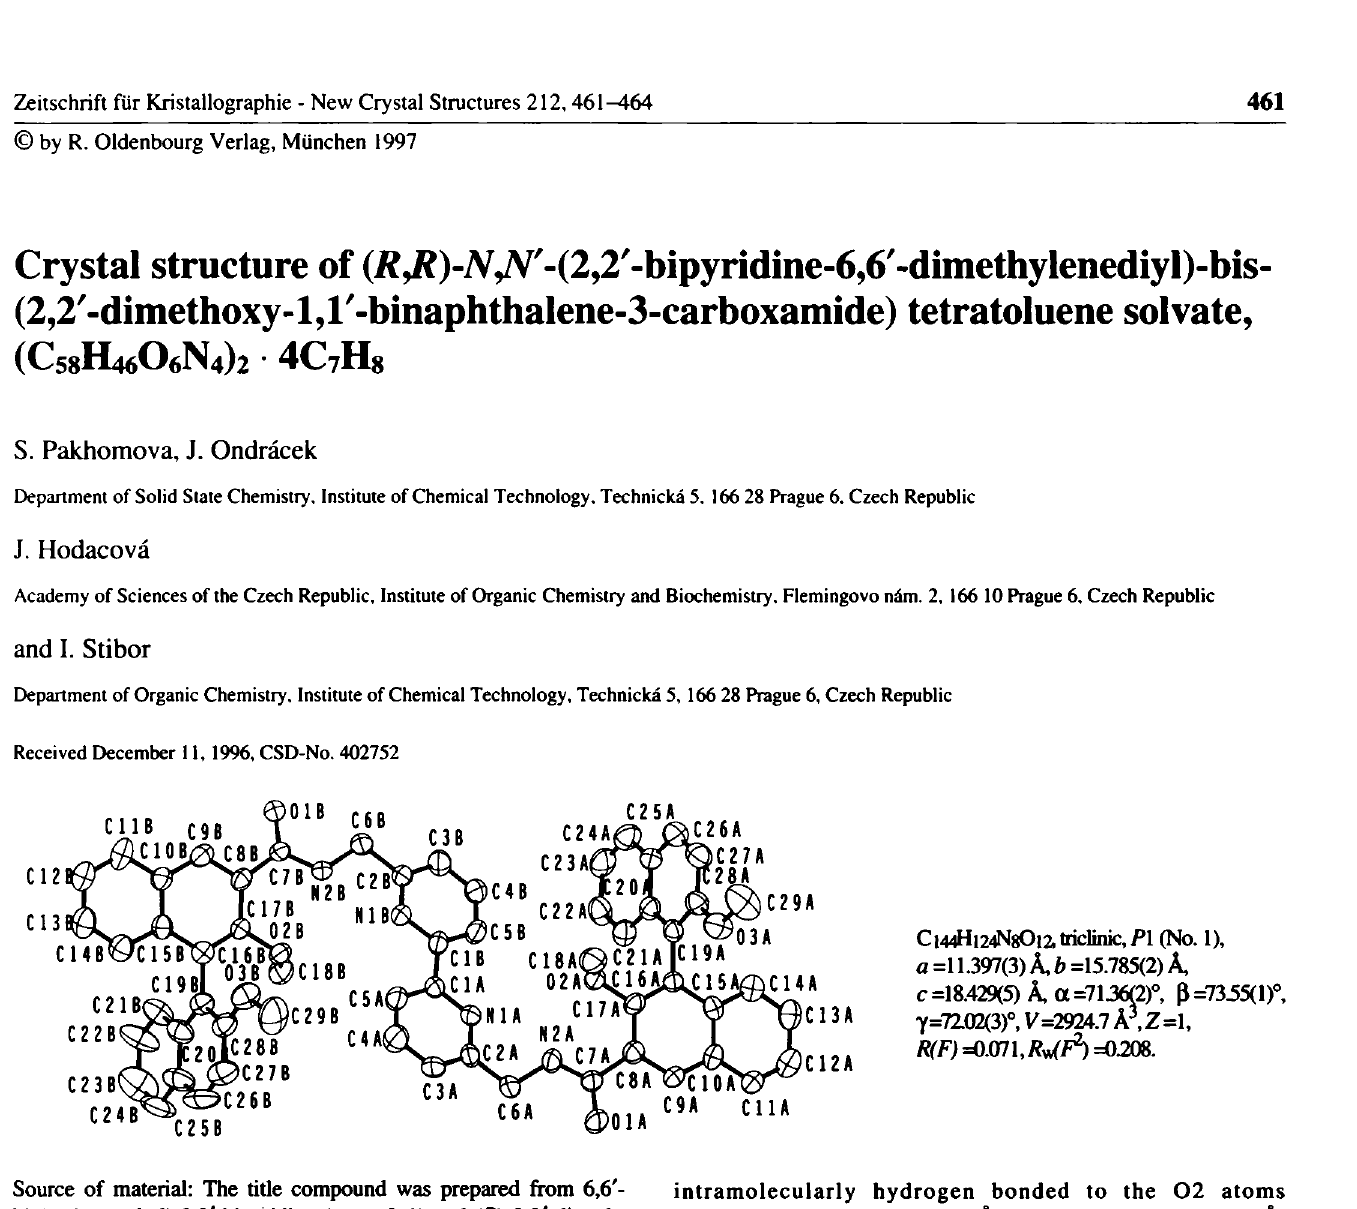
intramolecularly hydrogen bonded to the 02